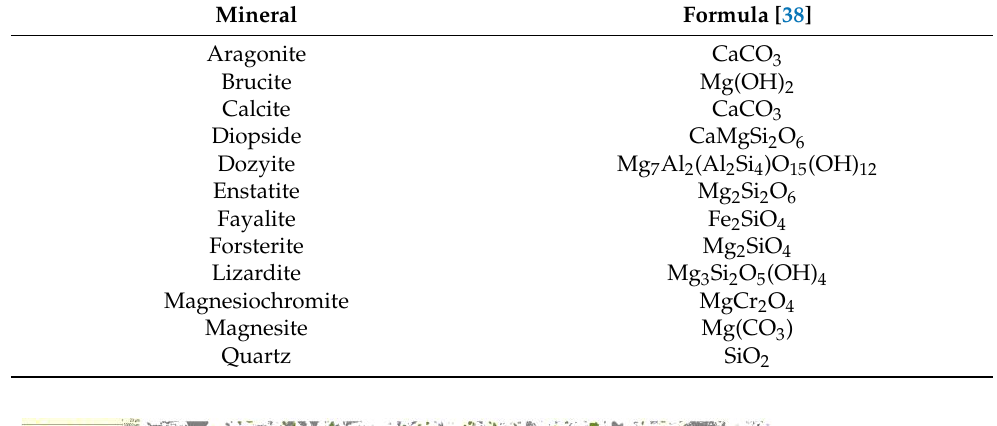
Table 1. Minerals identified by Raman microscopy.